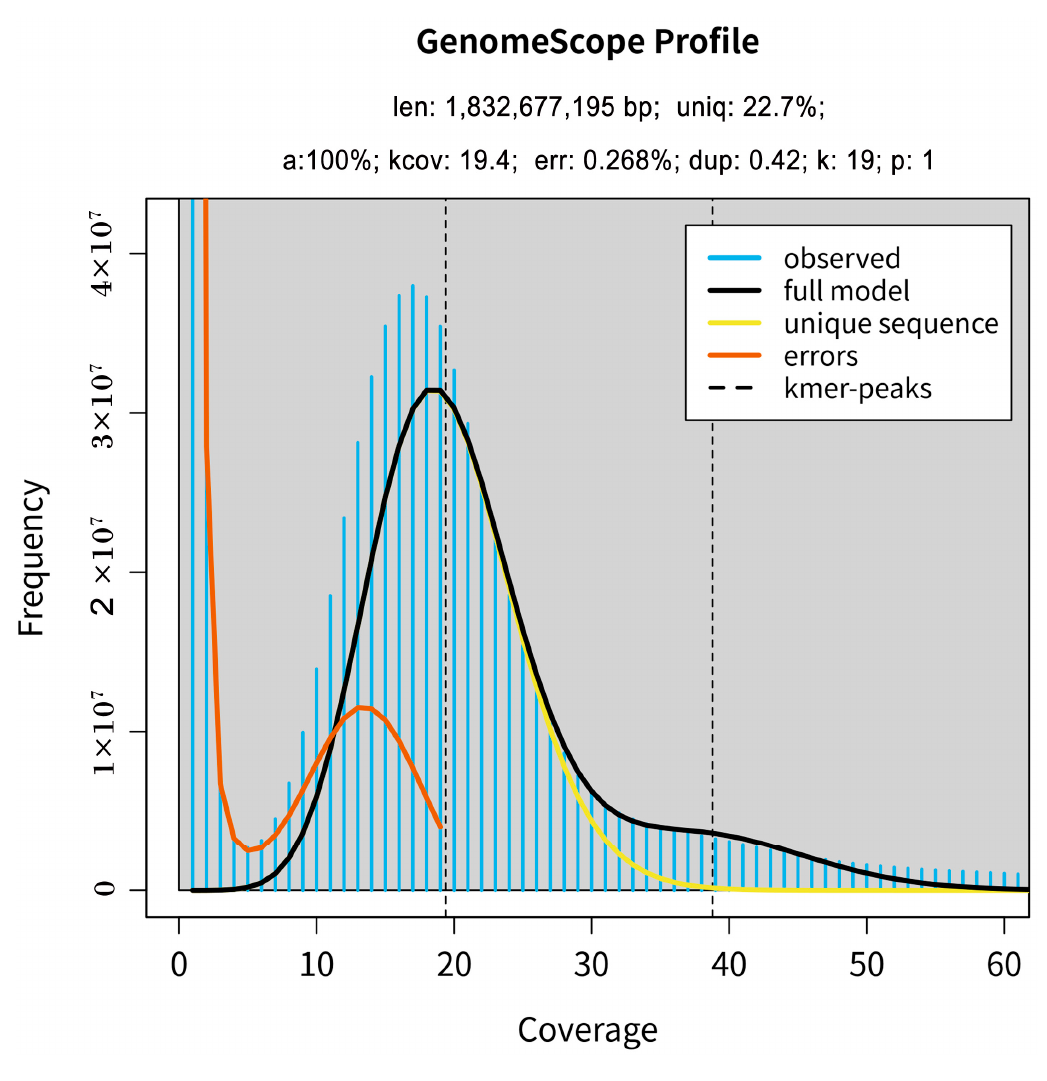
Figure 1. The distribution of K-mer = 17 depth. The estimated genome size = K-mer number/K-mer depth. The x-axis is depth; the y-axis represents the frequency at a particular depth divided by the total frequency of all depths.